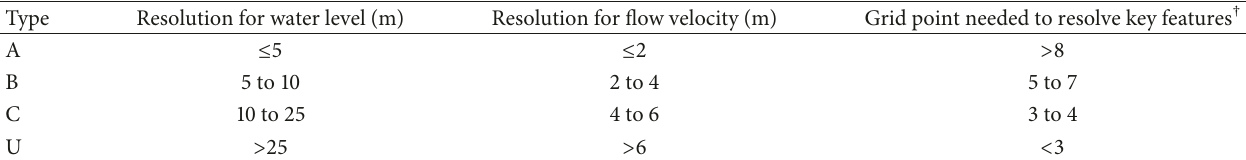
Figure 3: (a) Measured median grain size, D 50 , obtained from seabed samples and (b) the derived drag coefficient, C d , which accounts for D 50 and bedforms detected in a multibeam Table 3: Recommended model grid resolution for flood studies in estuaries (A � design; B � appraisal; C � strategy; and U � unsatisfactory); from Defra/EA [3].